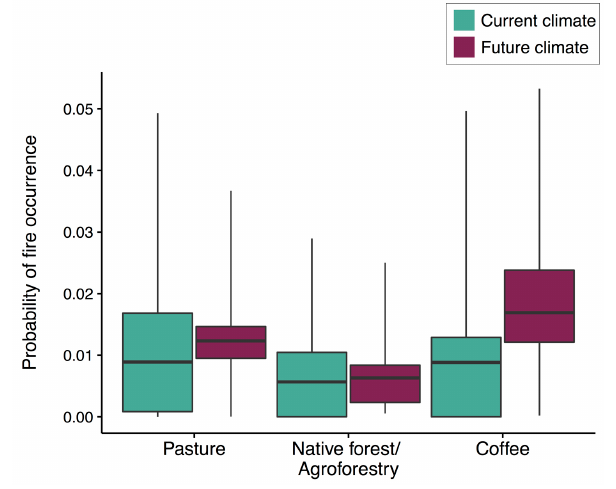
Fig. 3. Landscape flammability (the distribution of the per pixel probability of annual fire occurrence) under different land-use scenarios, based on grassland flammability predictions to characterize pasture, forest flammability to characterize native forest and agroforest (combined), and shrubland flammability to characterize coffee. The center lines indicate median values, the box indicates lower (25th) and upper (75th) quartiles, and the whiskers indicate minimum and maximum